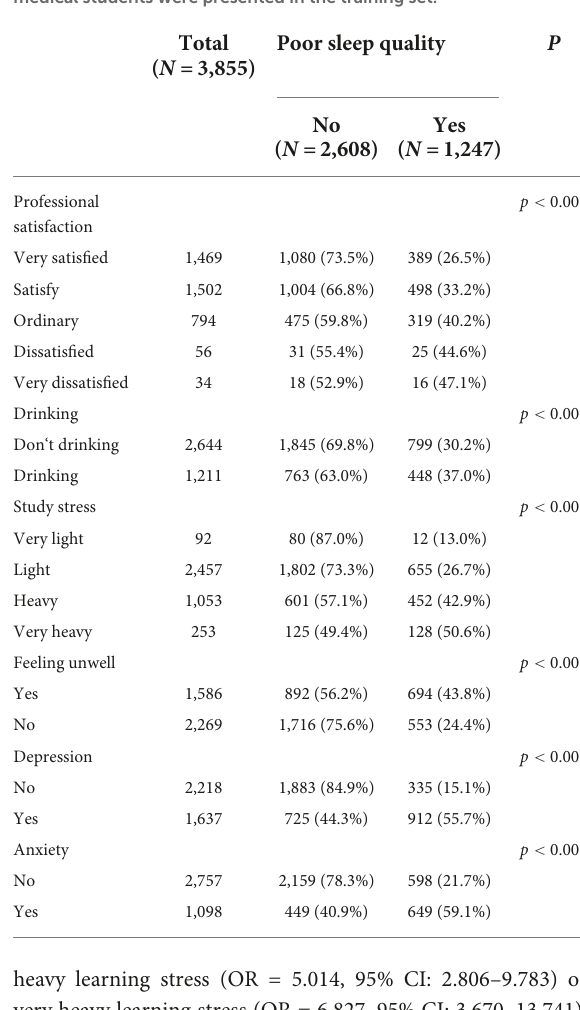
TABLE 2 The comparison of characteristics of the sleep quality medical students were presented in the training